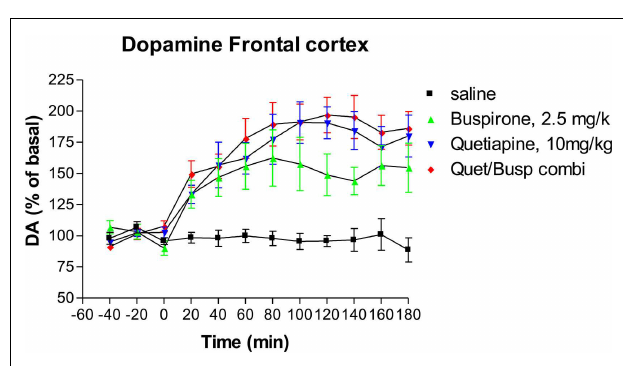
FIGURE 3 |The effect of Buspirone (2.5mg/kg i.p.) alone ( n = 7), Quetiapine (10mg/kg i.p.) alone ( n = 7), the combination of these two drugs (Busp/Quetcombi; n = 7), and saline vehicle control (saline; n = 9) on extracellular levels of dopamine in rat frontal cortex. Drugs were administered at time zero, values are means ± sem. Both the buspirone alone and quetiapine alone group were statistically different from saline controls. However, there were no statistically significantly differences between the combination of buspirone and quetiapine from either drug when given